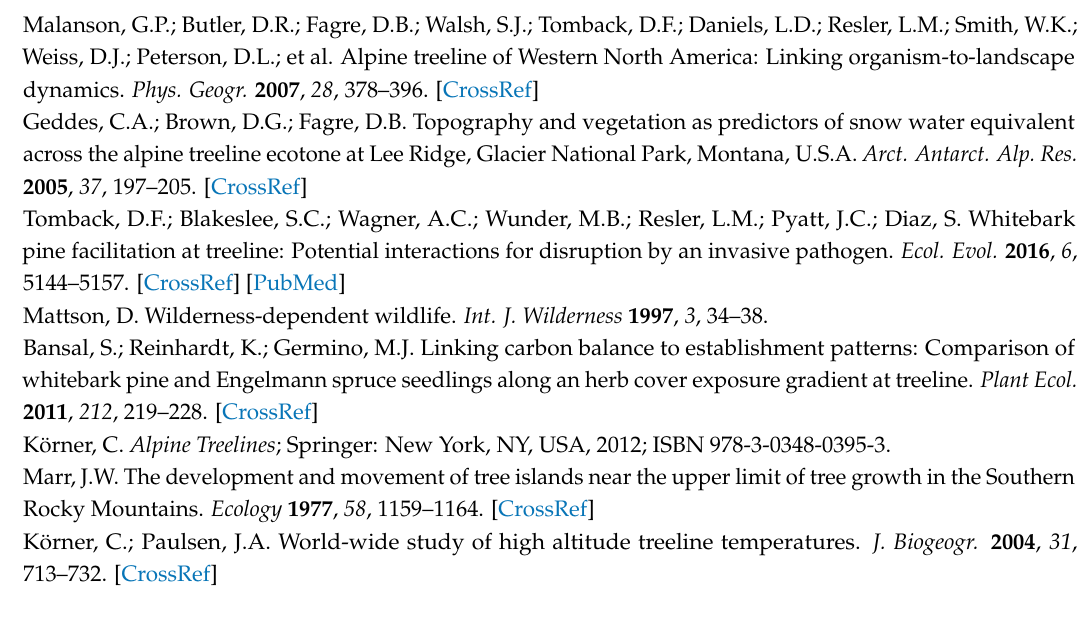
Figure S1: (A) Total conifer counts by species for each study area. (B) Total nurse object and unprotected site